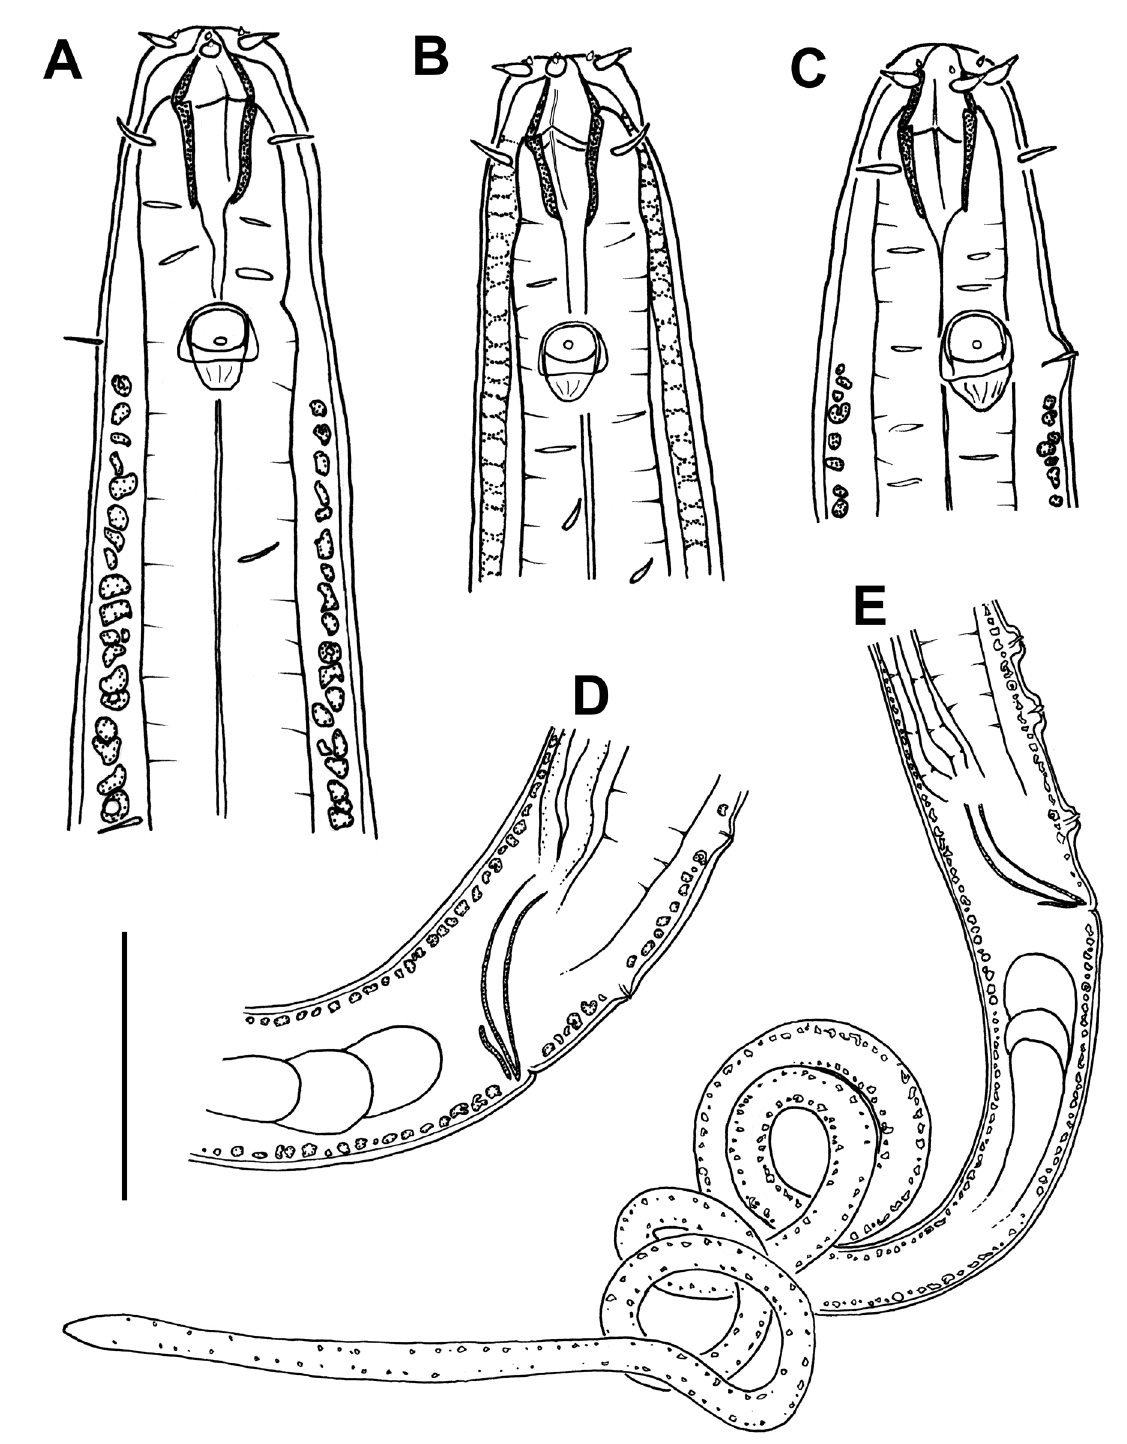
Fig. 6. Halanonchus scintillatulus Leduc sp. nov. A . ♀, cephalic region, paratype (NNCNZ3329). B. ♂, cephalic region, holotype (NIWA 139240). C . ♂, cephalic region, paratype (NIWA 139241). D . ♂, copulatory apparatus, holotype. E . ♂, posterior body region, holotype. Scale bars: A–C = 20 μm; D = 35 μm; E = 45